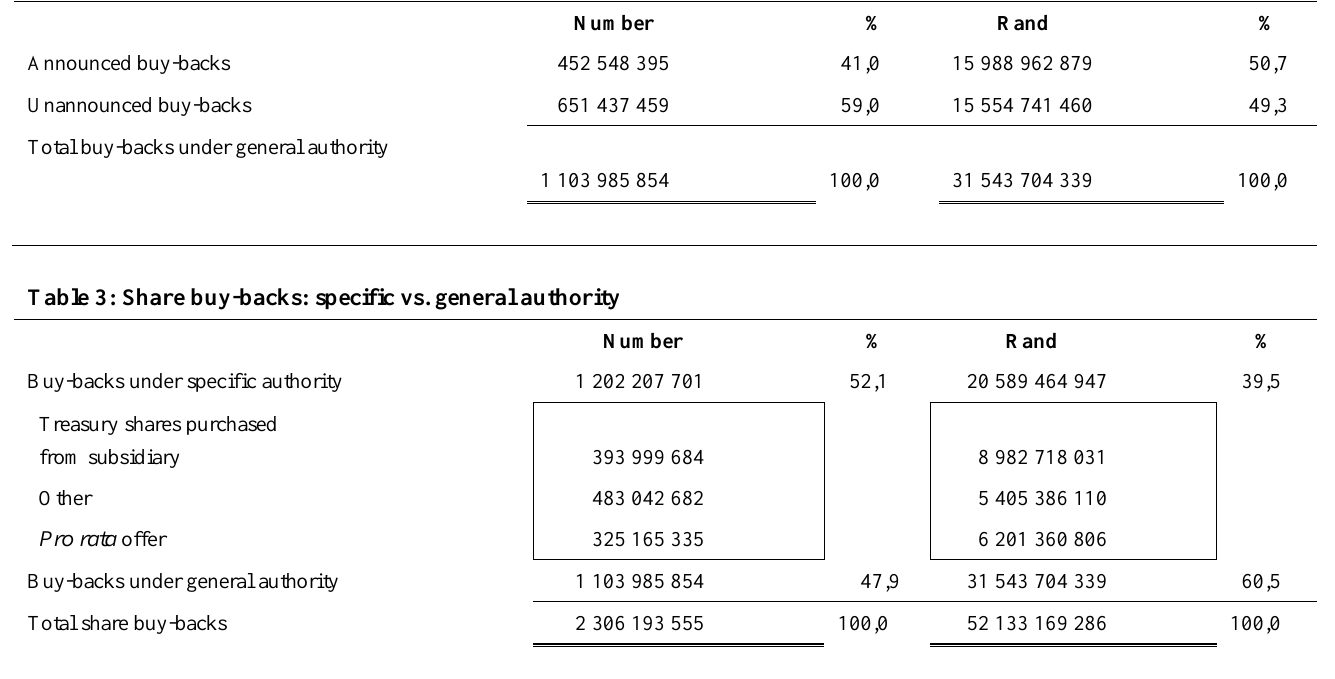
Table 2: Share buy-backs under general authority